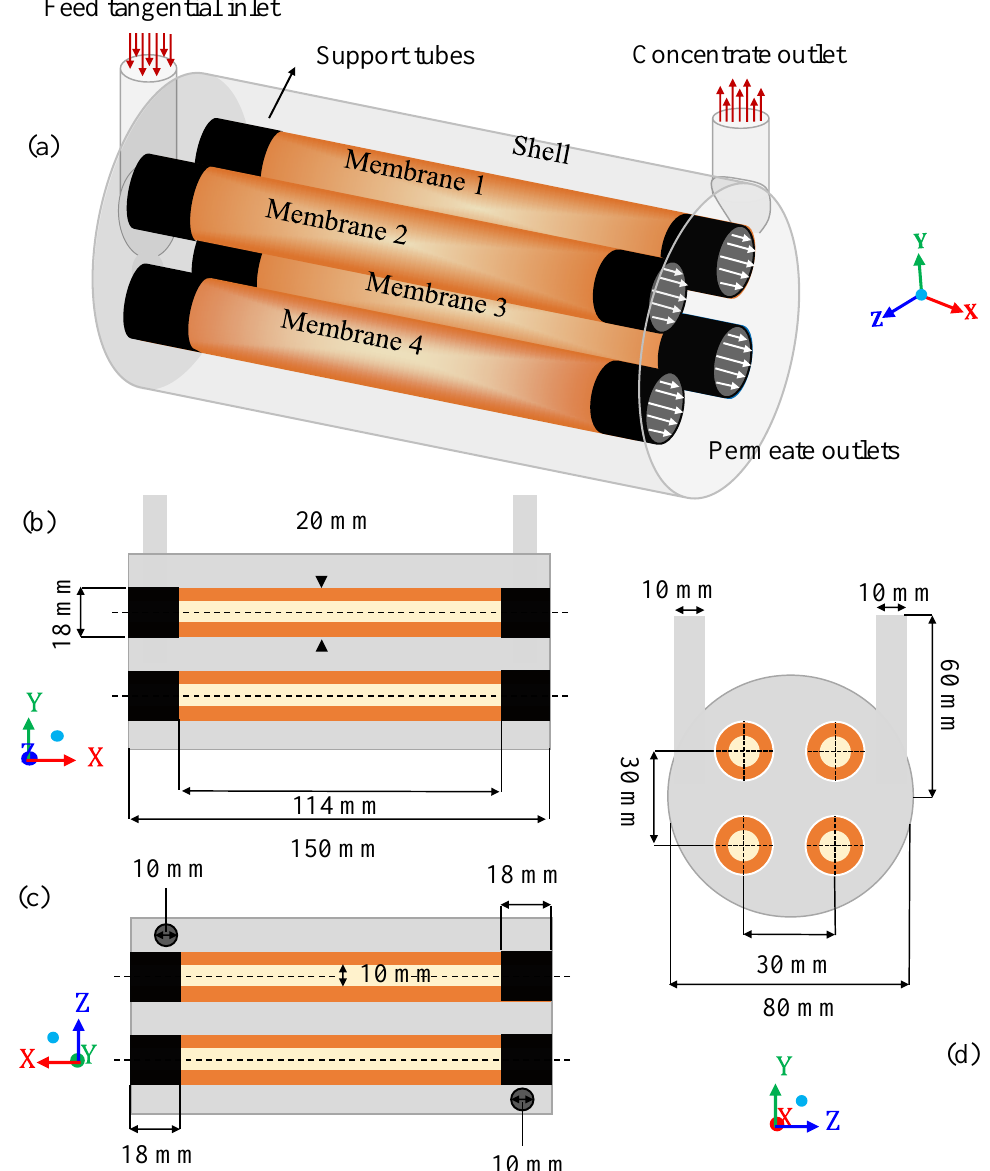
Figure 1. Scheme of the geometry of the separation module and its dimensions ( a ) Permeation module, ( b , c ) Longitudinal views of the permeation module, ( d ) Frontal view of the permeation module.